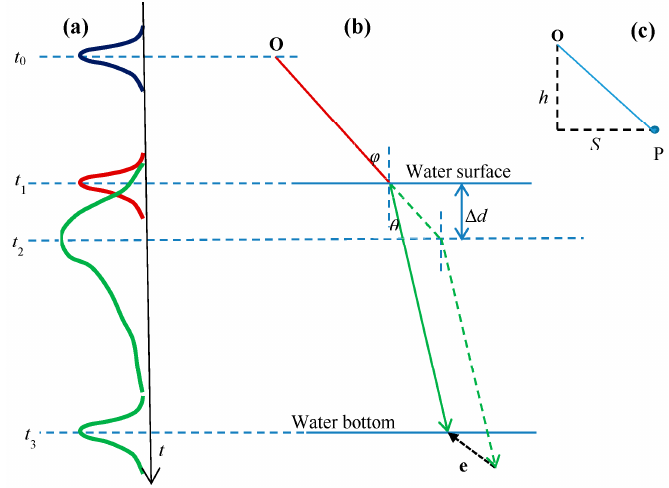
Figure 1. Measurement mechanism of the airborne Light Detection And Ranging (LiDAR) bathymetry (ALB) system. The red and green colors represent the infrared (IR) and green lasers, respectively: ( a ) denotes the waveform detections of the IR laser and green laser; ( b ) shows the propagation ways of the two lasers and the bias induced by using only the green laser; ( c ) shows the location of the beam point P relative to the scanner origin O; t 0 – t 3 denote the initial emission time of the laser pulse, round trip time of the IR surface return, round trip time of the green surface return and round trip time of the green bottom return, respectively; φ and θ are the incidence angle in the air and the refracted angle in the water, respectively, of the green laser; Δ d is near water surface penetration (NWSP); and S and h denote the horizontal distance and vertical distance, respectively, of the beam point P relative to O.